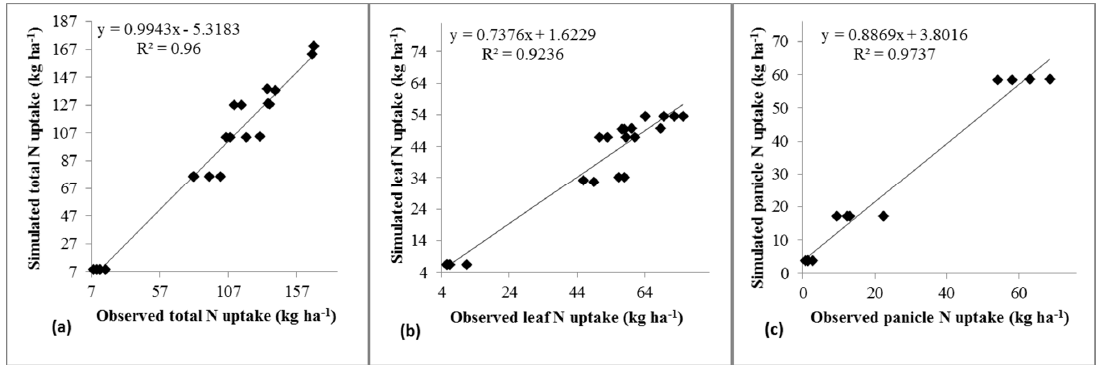
Figure 4. Simulated vs. observed total N uptake, leaf N uptake and panicle N uptake, ( a , b , c ) for 2008 validation period, in Kunshan, Nanjing, China.